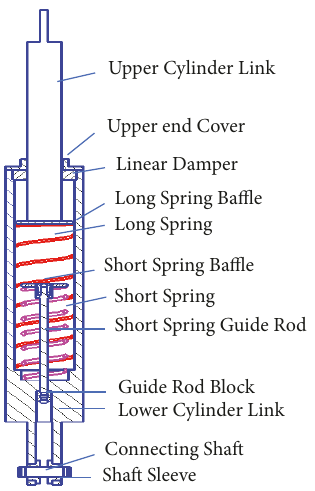
Figure 2: CAD model of the energy-storing device.